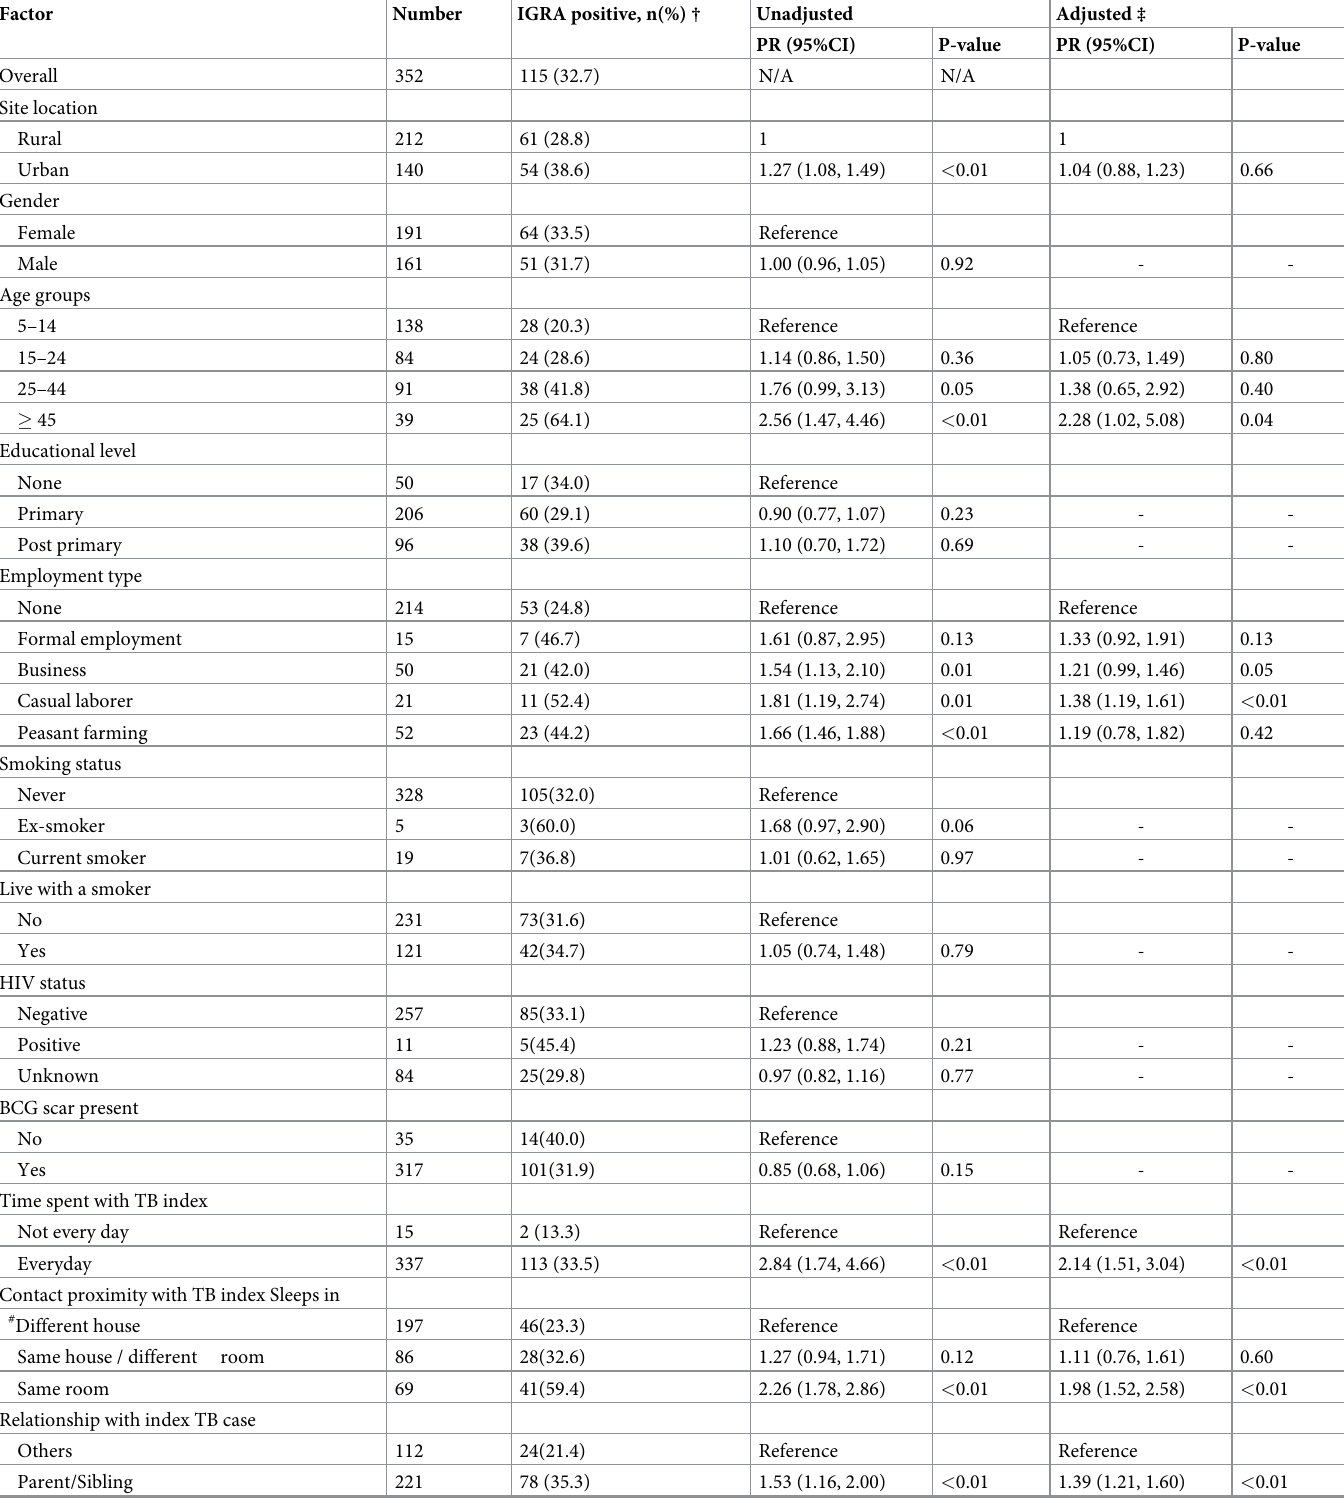
Table 3. Factors associated with latent TB infection among household contacts of patients with bacteriologically confirmed